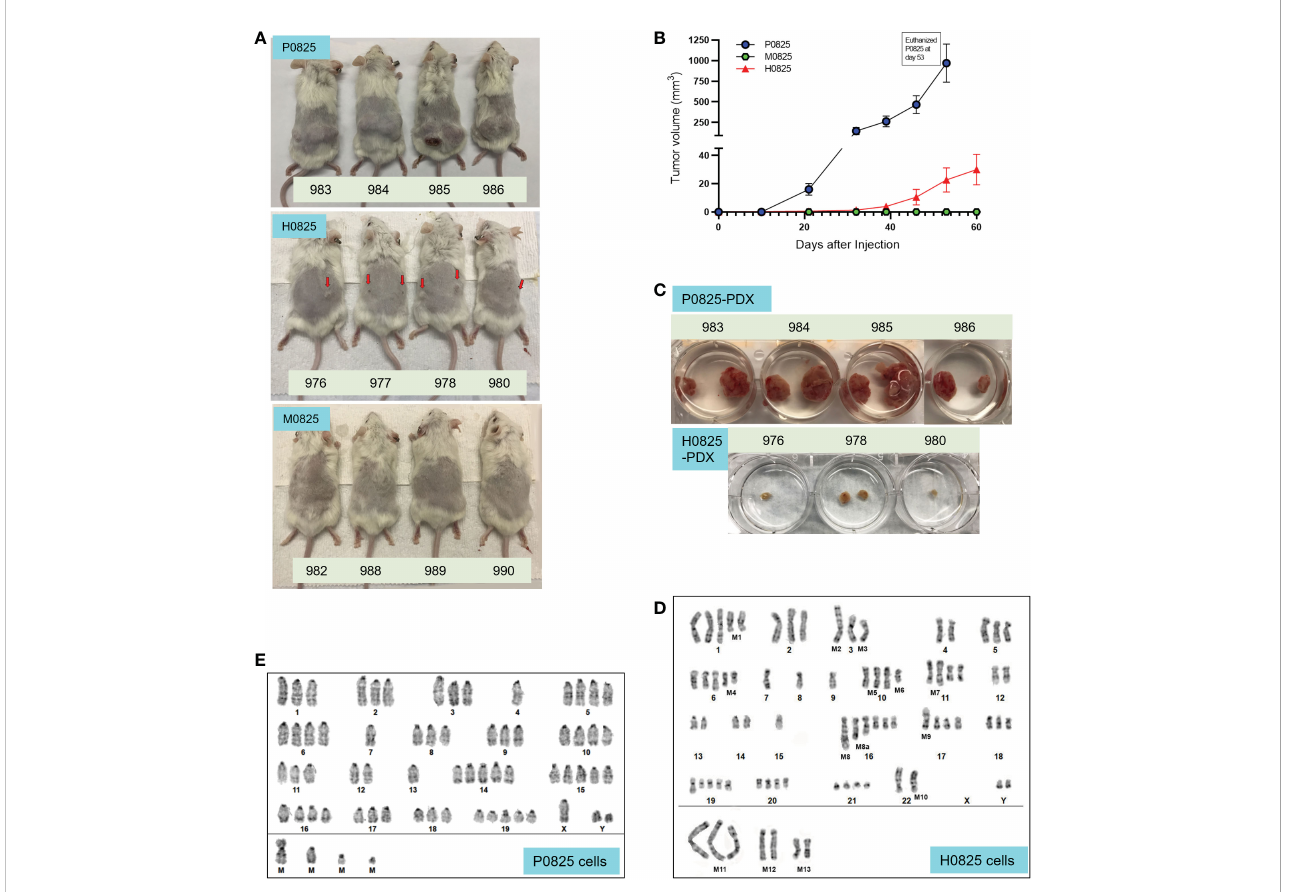
FIGURE 3 From a common GA082516-PDX-G1, three descendent subpopulations generated PDX models, their tumor size progression and G-banded karyotyping analyses of P0825 and H0825 cells. (A) Murine P0825, human H0825, and murine M0825 cells were injected into SCID mice subcutaneously to generate PDX models. Red arrows in H0825 pointed to the tiny bumps of possible tumors. (B) Time progression of tumor sizes in mice generated by human H0825, murine P0825, and M0825 cells. (C) Tumors excised from PDX mice at time of sacri fi ce showing tumors from murine P0825- and human H0825-generated PDXs. (D) G-banded karyotyping analysis of human H0825 cells. (E) G-banded karyotyping analysis of murine P0825